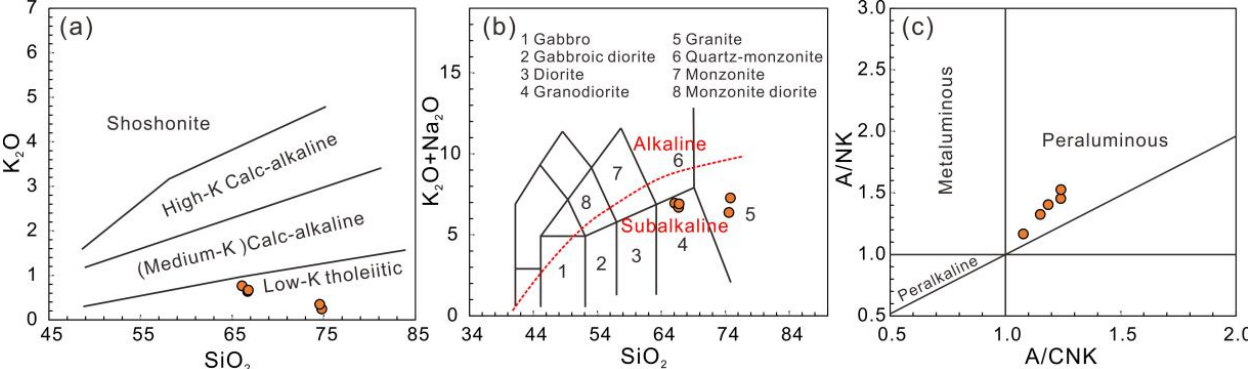
Figure 10. Major element diagrams for the granitic pebbles in the conglomerate. ( a ) K 2 O versus SiO 2 diagram (after Peccerillo and Taylor, 1976 [88]); ( b ) TAS classification diagram (after Middlemost, 1994 [89]); ( c ) ANK versus ACNK diagram (after Maniar and Piccoli, 1989 [90]).